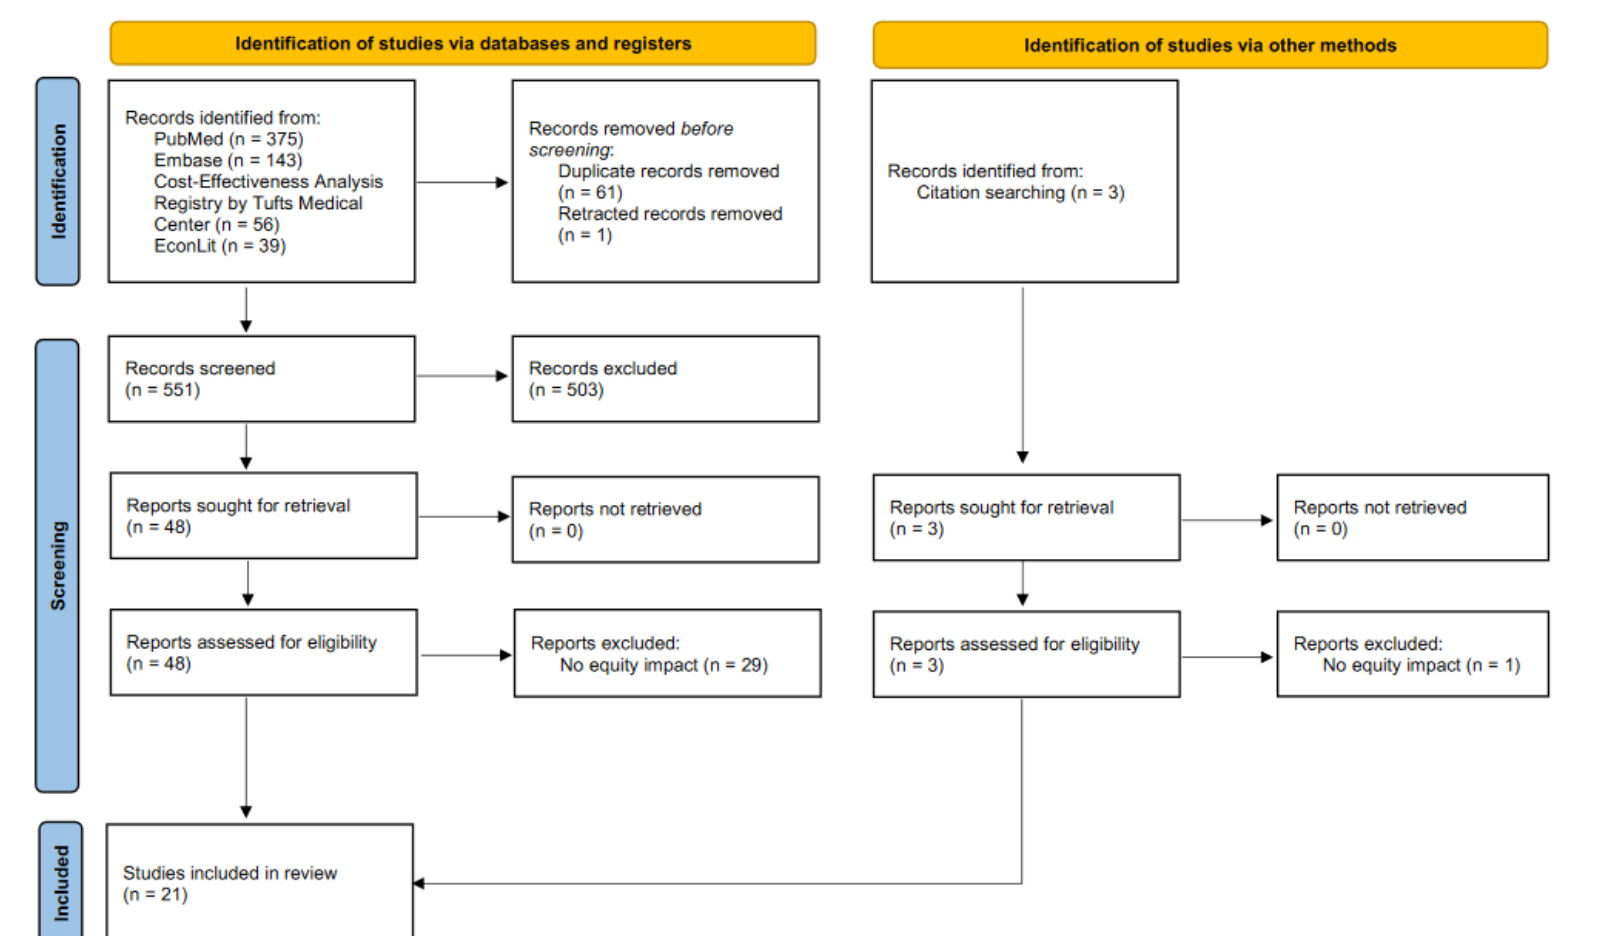
Figure 1. Study selection flow diagram.